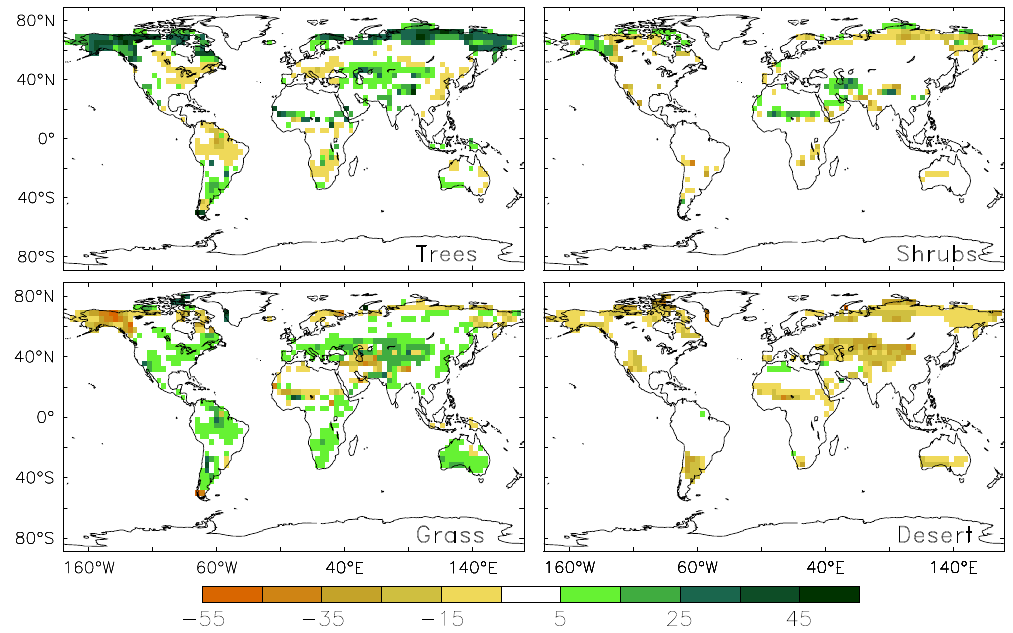
Fig. 4. Differences in absolute vegetation cover between the DYN and the CTL simulation averaged over the period from the year 2090 until 2119 given in